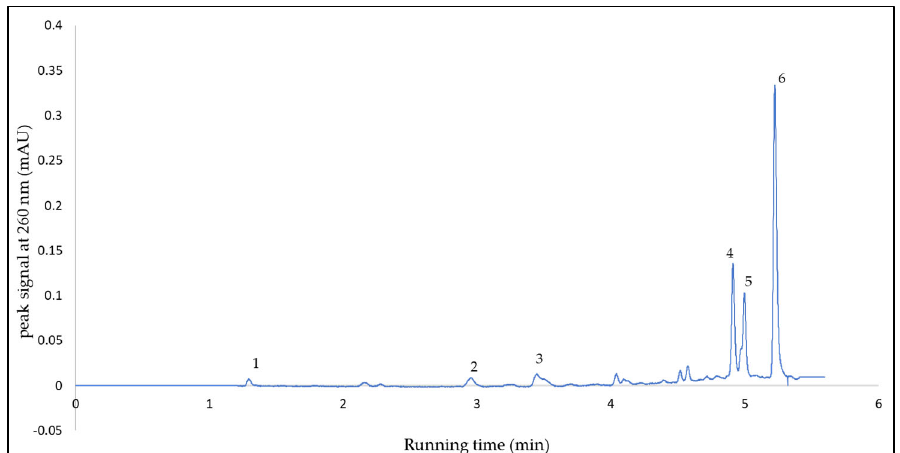
Figure 3. Chromatogram of identified phenolic compounds: protocatechuic acid (1), catechin (2), chlorogenic acid (3), and caffeic acid derivatives (4,5,6).